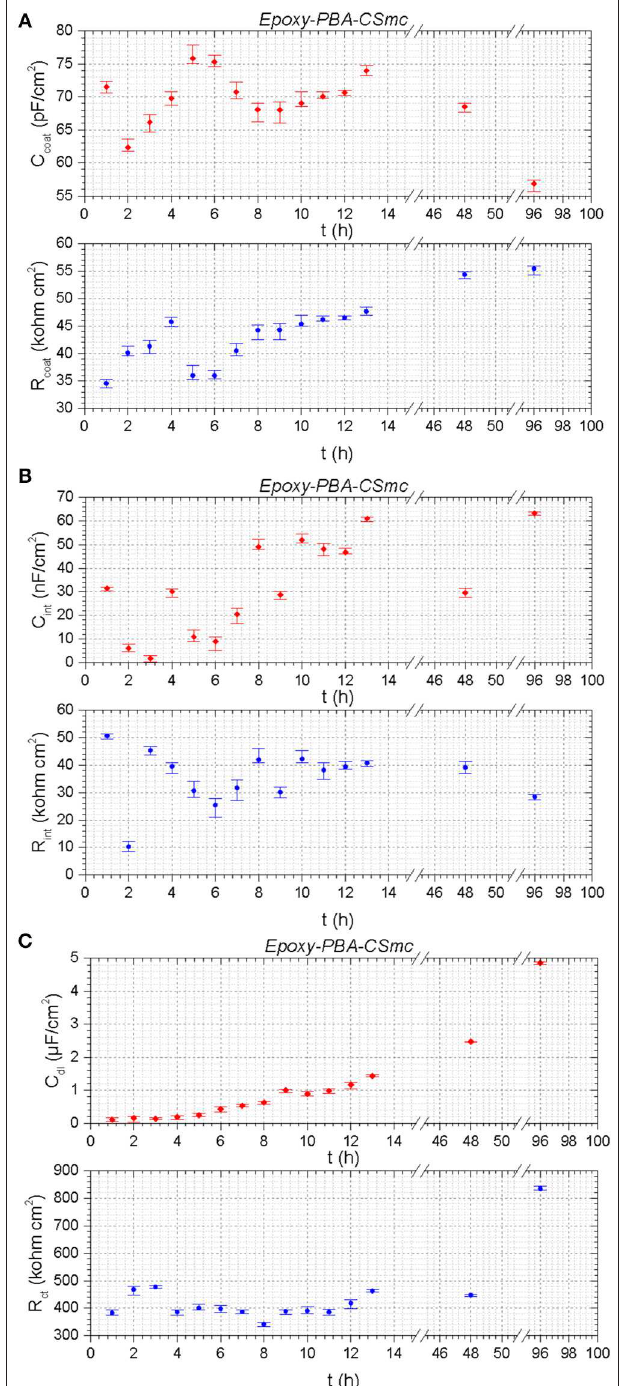
FIGURE 8 | The evolution of the EIS fitting parameters as a function of time of artificially scribed Epoxy-PBA-CSmc : (A) R coat , C coat ; (B) R int , C int ; (C) R ct , C dl .